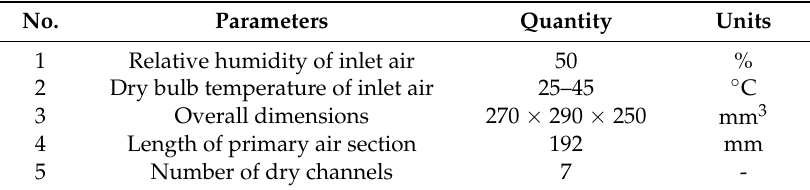
Table 5. Operating and geometric parameters for the experimental results from Qui [45].